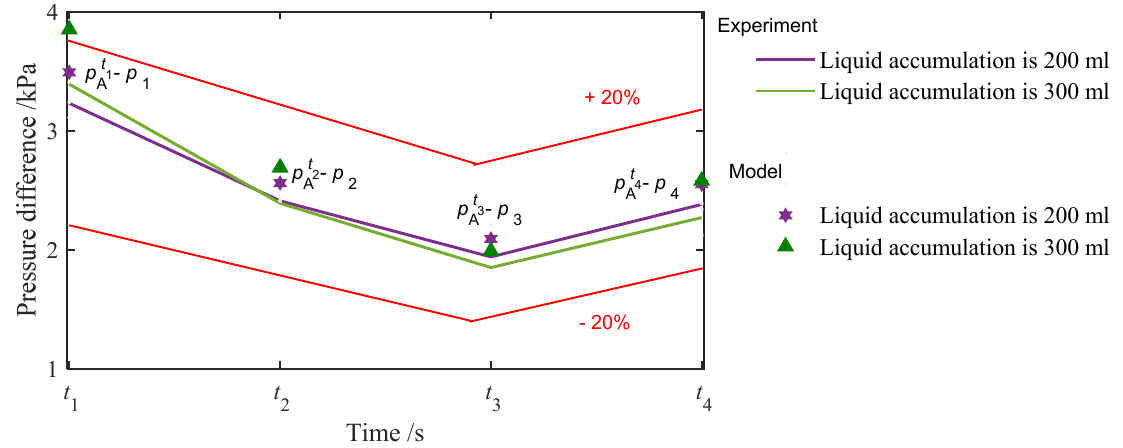
Figure 13. Verification of slug flow pressure model with an inclination of 20°.